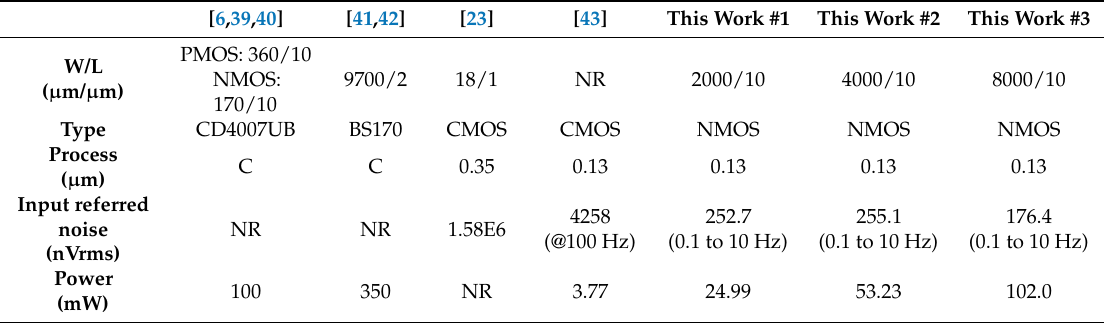
Table 1. Characteristics of the proposed extended-gate field-effect transistor (EGFET) devices compared to commercial and non–commercial